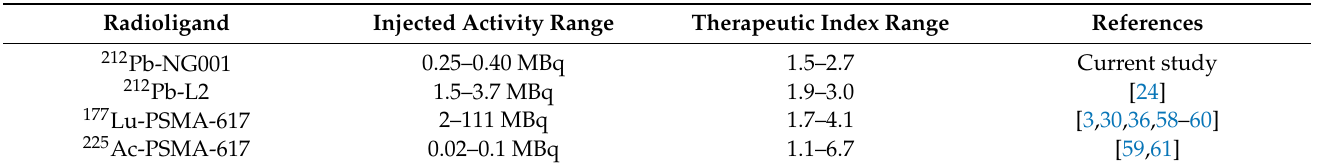
Table 4. Therapeutic effect of various radiolabelled PSMA ligands in different subcutaneous animal models. Table S1 provides details of the mouse strains and cell lines used and specific activities in each individual study. The therapeutic index (TI) is calculated as the median survival of the treatment group divided by that of the control group.